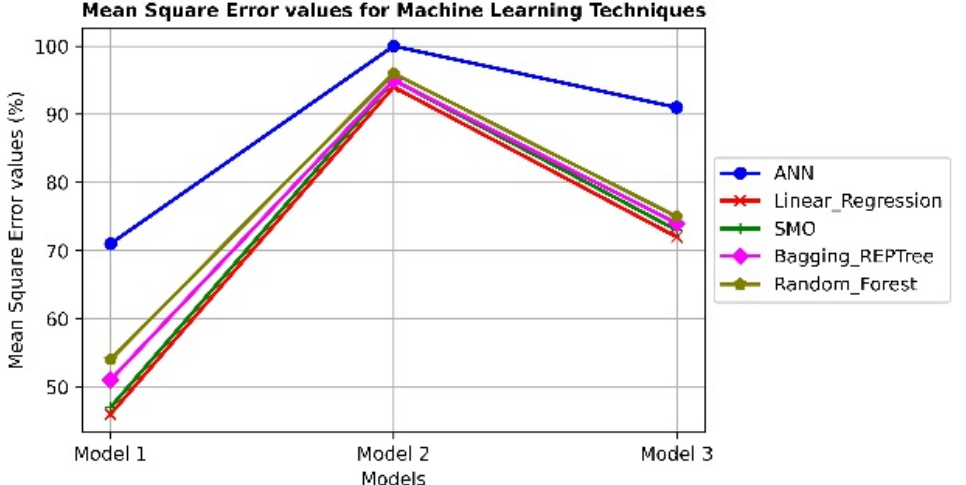
Figure 4. The results of (MSE) using ML techniques on Social Isolation dataset.